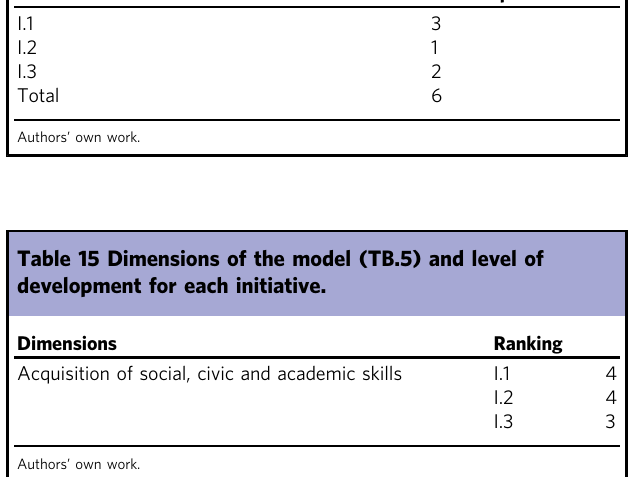
Table 14 Pupils who relate landscape with emotions.